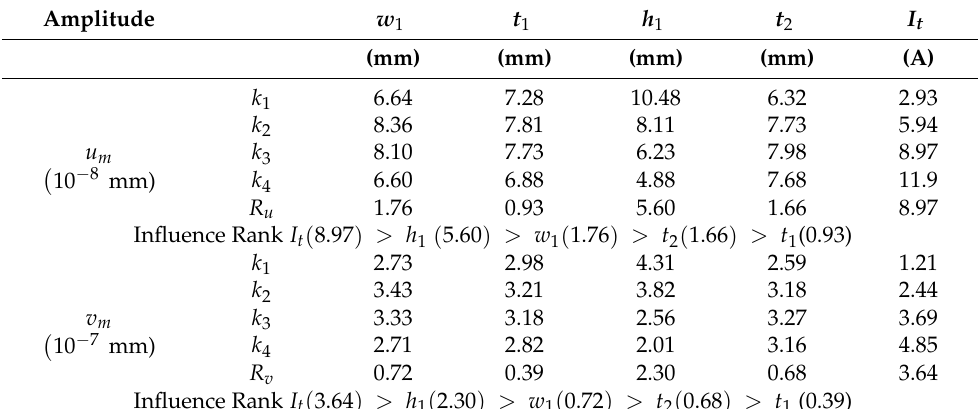
Table 4. Analysis of orthogonal test results.